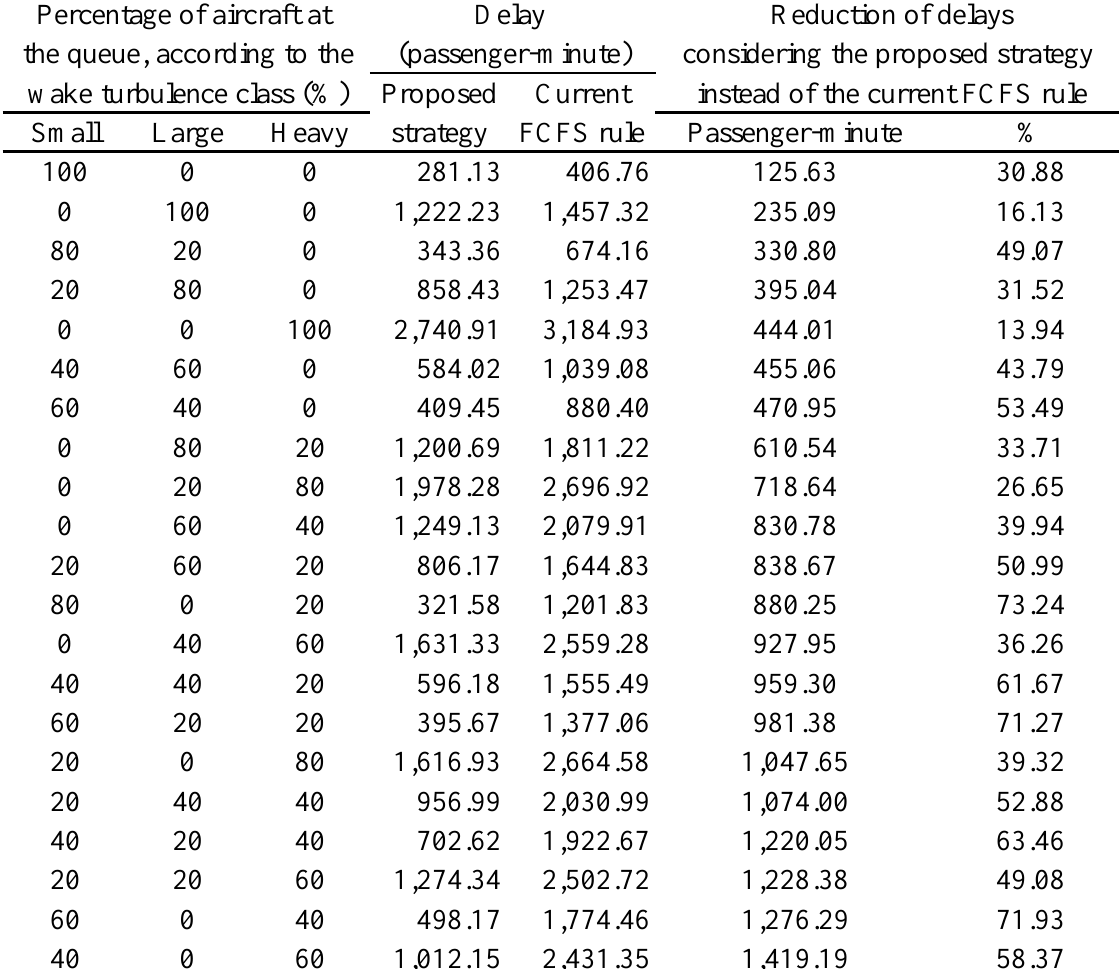
Table 3. Delays obtained for a queue of five aircraft considering the current FCFS rule and the strategy proposed